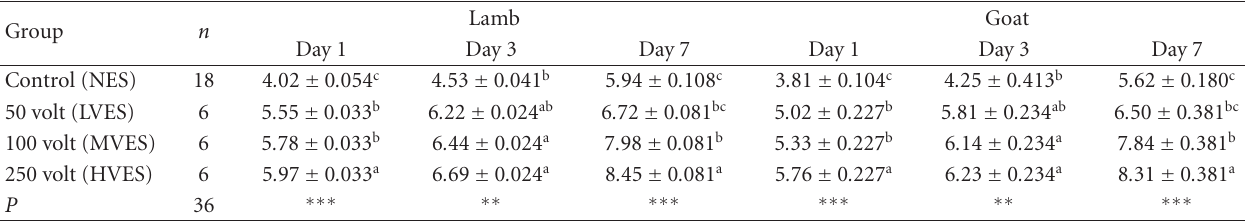
Table 4: Mean and standard errors of drip loss (DL) values in lamb and goat meat during aging at 4 ◦ C (%). Lamb Goat Group n